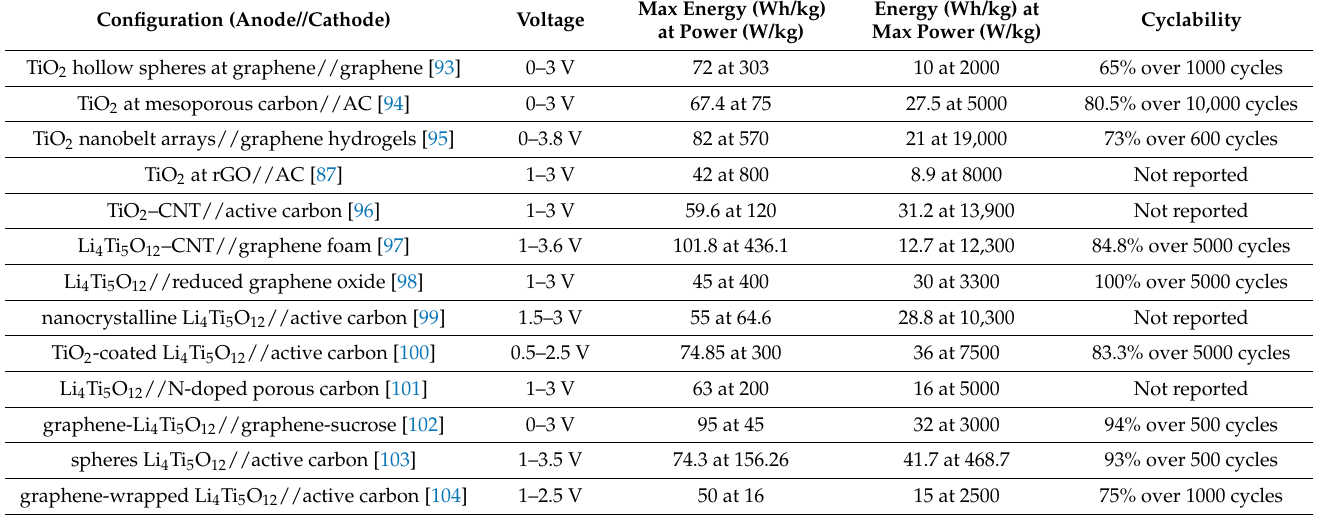
Table 2. Transition metal-based LIC